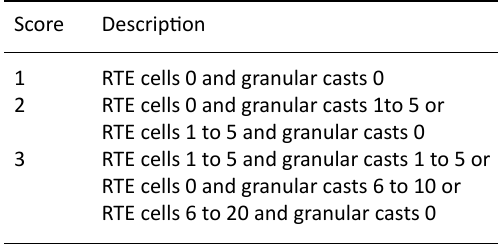
Table 1. Perazella scoring system based on number